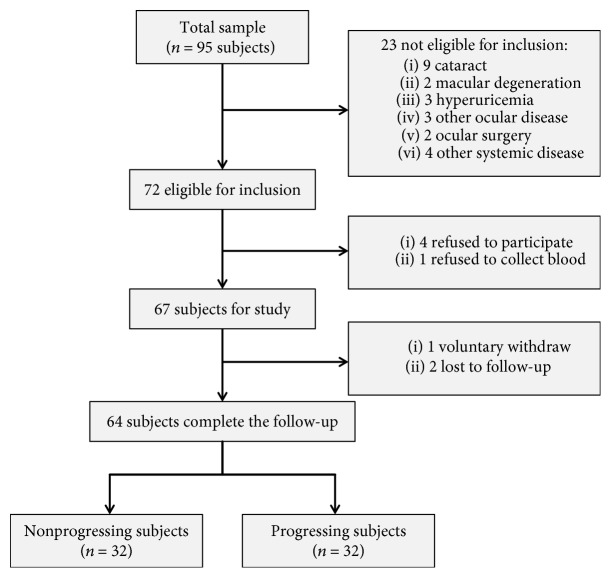
Study flow diagram.